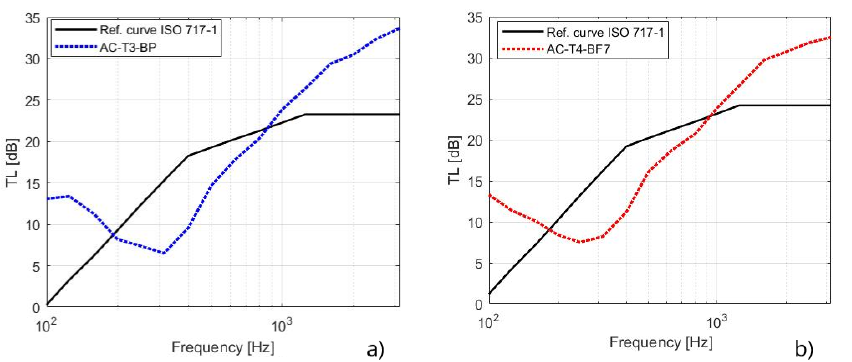
Figure 8. Comparison of the measured sound transmission loss TL with the reference curve defined in the ISO 717-1 [47] standard for the determination of the weighted sound reduction index R w for panel AC-T3-BP ( a ) and panel AC-T4-BF7 ( b